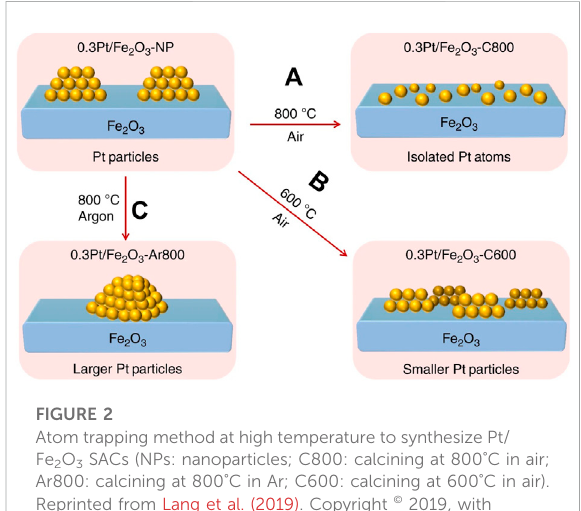
FIGURE 2 Atom trapping method at high temperature to synthesize Pt/ Fe 2 O 3 SACs (NPs: nanoparticles; C800: calcining at 800 ° C in air; Ar800: calcining at 800 ° C in Ar; C600: calcining at 600 ° C in air). Reprinted from Lang et al. (2019). Copyright © 2019, with permission from Springer